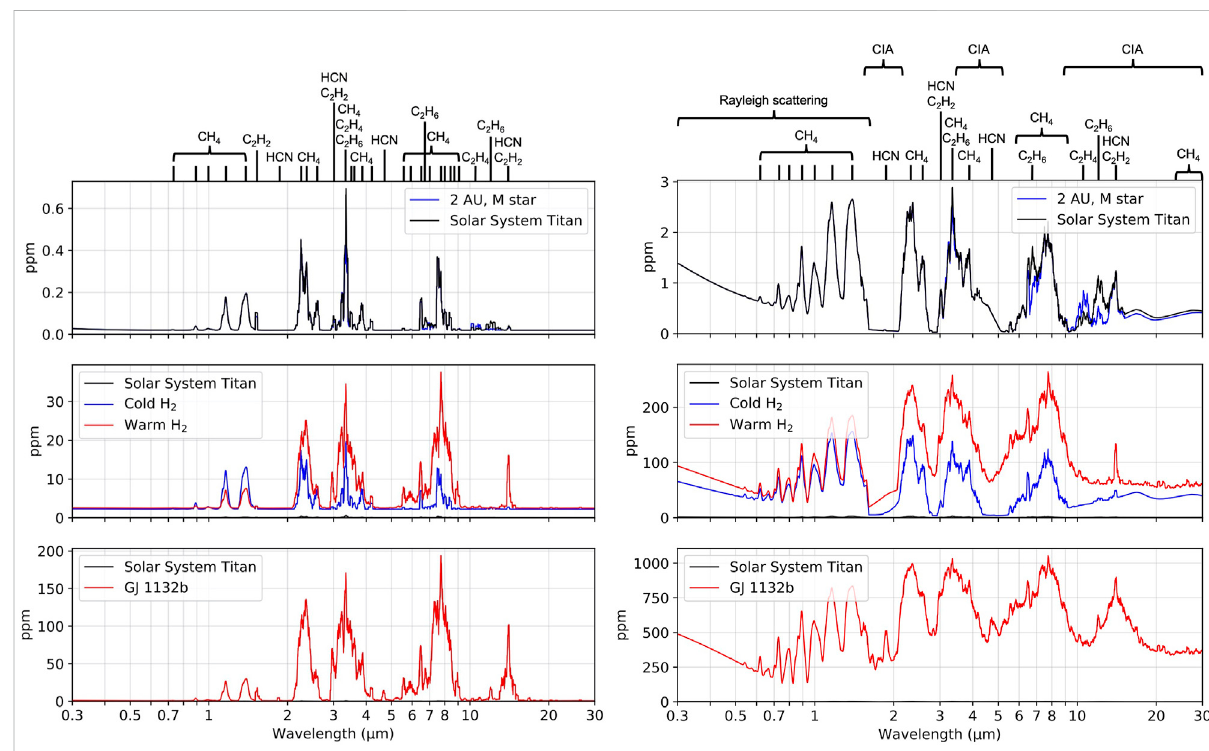
FIGURE 15 Computedtransmissionspectraforthebookendexo-Titancasespresentedinthispaper(upper)solarsystemTitanvs.a2 AUorbitaroundanM star;(middle)solarsystemTitanvs.acoldH 2 -dominatedatmosphere(blue)vs.awarmH 2 dominatedatmosphere(red);(lower)solarsystemTitanvs. GJ 1132b. Notice the different y -axis scales, where thespectral features in theupper panel arewellbelow detection thresholds and spectralfeatures in the middle and the lower panels are much larger and potentially detectable with JWST. The absorption regions of detectable species are labeled above the uppermost panel. CIA, collision-induced